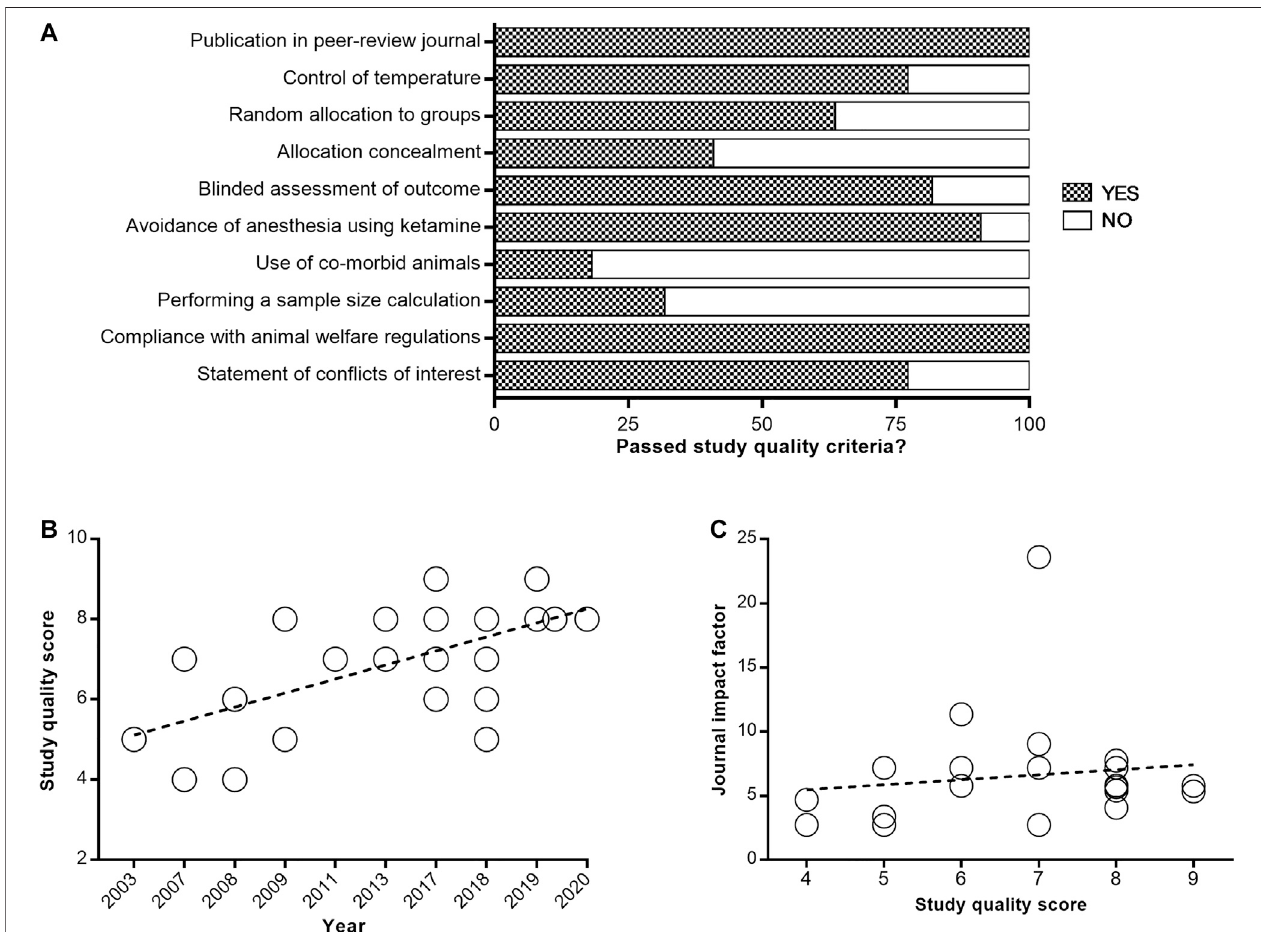
FIGURE 2 | Quality assessment of enrolled studies. Study quality was assessed using the CAMARADES checklist (A) . Values are expressed as the percentage of studies reporting each quality indicator. The correlation of study quality with year of publication (B) and journal impact factor (C) .